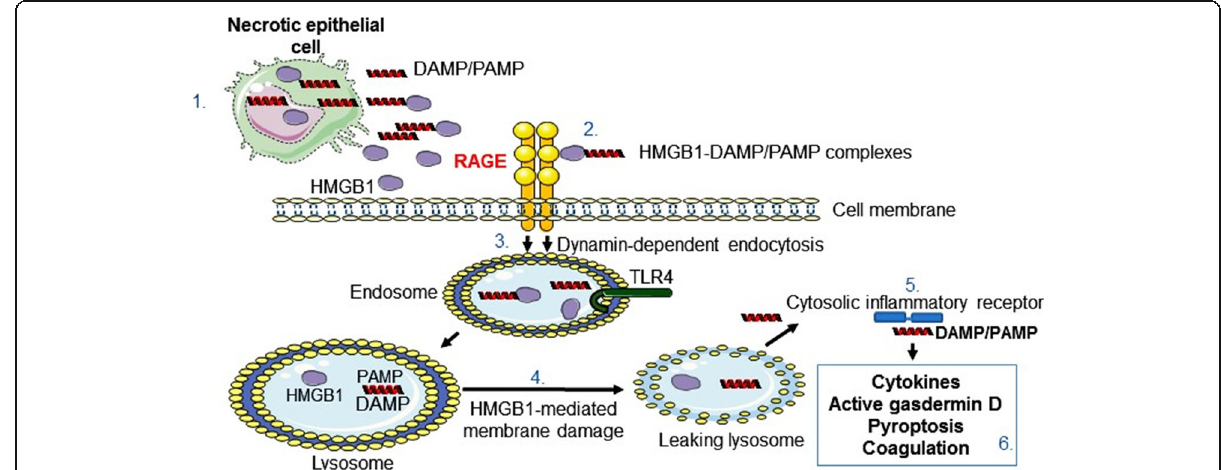
Fig. 1 Inflammation induced by HMGB1-partner molecule complexes. Necrotic cells release DAMP and PAMP molecules extracellularly where they form complexes with HMGB1 released from dying or activated cells (1); these complexes bind to RAGE abundantly expressed in the lungs (2); and get endocytosed to endosomes having TLR receptors including TLR4 which may be activated by HMGB1 (3); HMGB1 and partner molecules translocate to lysosomes, where HMGB1 acts like a detergent under the acidic conditions and disrupts the lysosomal membrane enabling HMGB1-partner molecules access to the cytosol (4); the translocated molecules bind and activate reciprocal cytoplasmic receptors generating inflammasome activation and additional proinflammatory events (5); the subsequent outcome production and extracellular release of cytokines via pore formation in the cell surface membrane accomplished by oligomerized gasdermin D. The final outcome is pyroptosis. Active gasdermin D also rotates and translocates phosphatidylserine molecules to the outside of the cell surface membrane and induces tissue factor on endothelial cells. This biology initiates coagulation